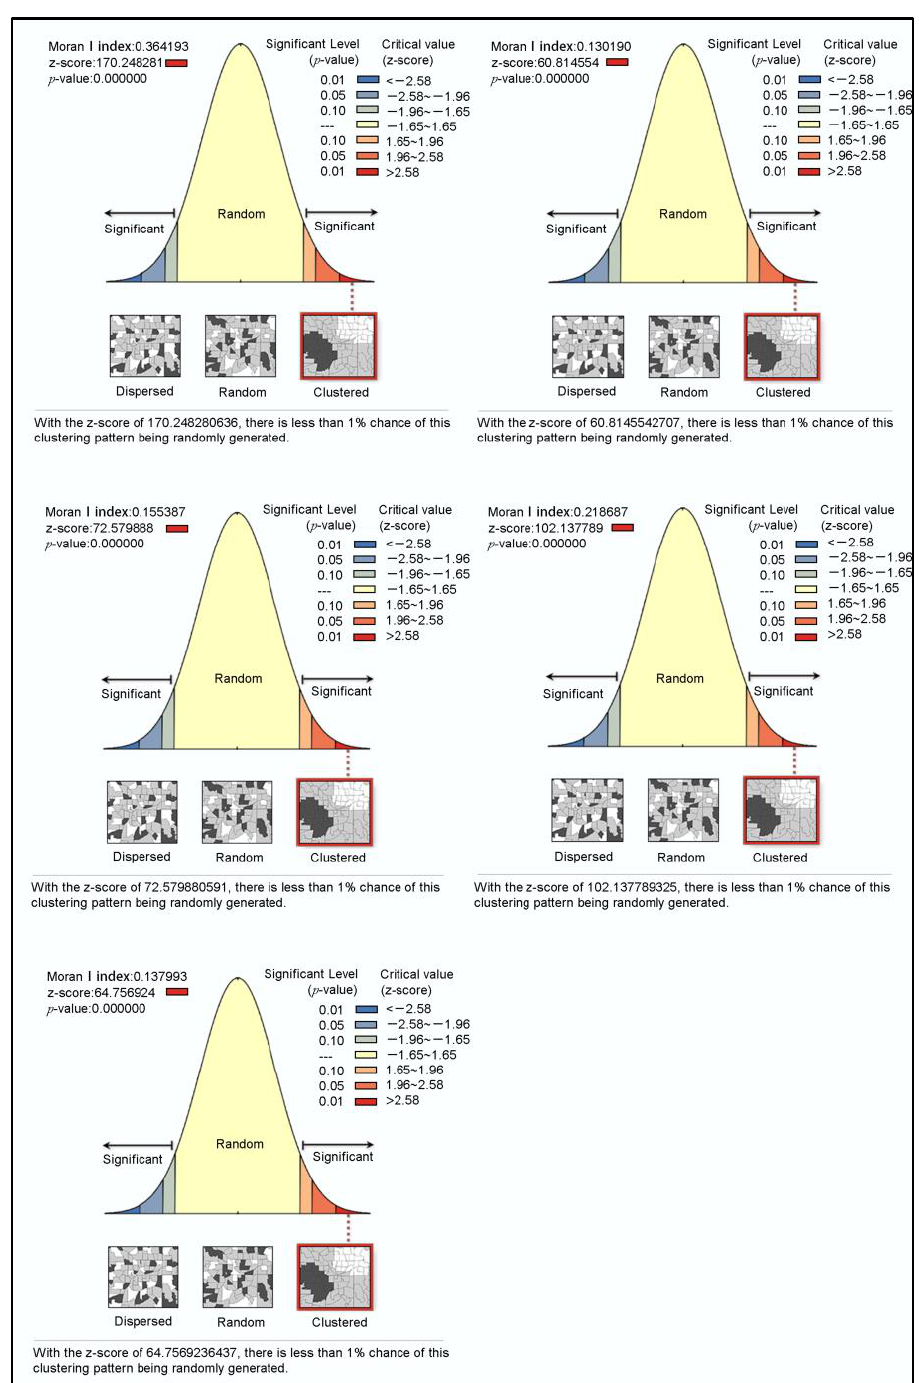
Figure 9. Results of the spatial autocorrelation analysis results (upper row, from left to right: the dependent variables, namely the number of reviews and sum of taste ratings; middle row, from left to right: the dependent variables, namely indoor environment rating and service rating; and bottom row, the dependent variable, consumption per capita).